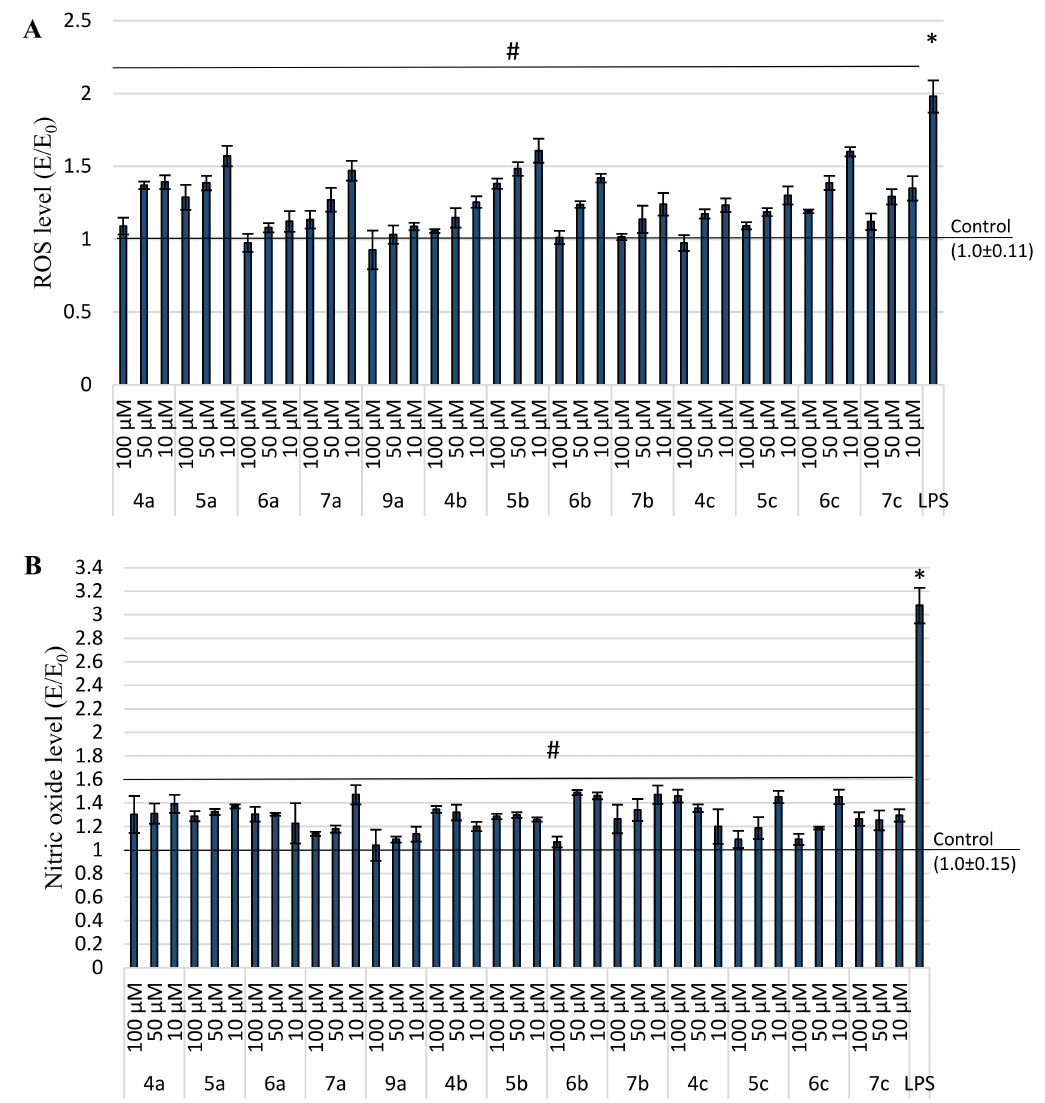
Figure 6. Impact of investigated compounds on NHDF cells after incubation with 50 µ g/mL LPS; ( A ) DCF-DA assay and ( B ) Griess assay; # p < 0.05—significant difference compared to the control with 50 µ g/mL LPS and without compounds; * p < 0.05—significant difference compared to a negative control without 50 µ g/mL LPS and